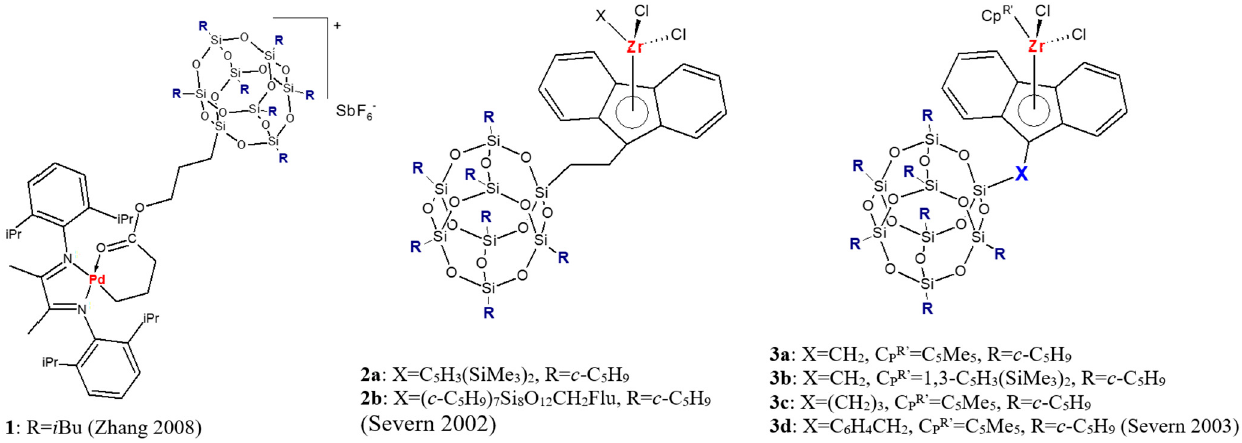
Figure 1. Homogeneous analogs of supported catalysts with silsesquioxane moiety used in olefin polymerization [34–36]. polymerization